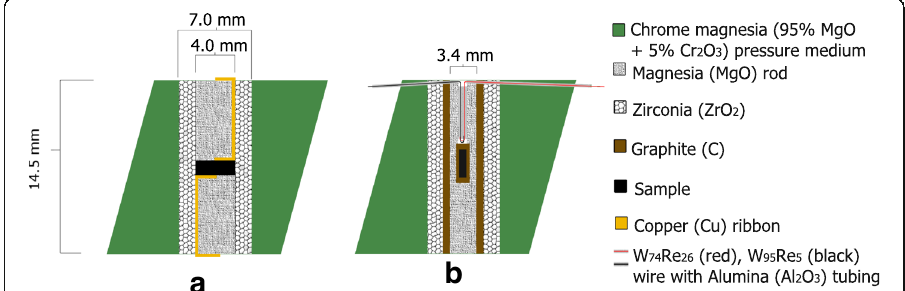
Fig. 3 Schematic assembly setup for the performed calibration experiments. a The 18/11 OEL/TEL assembly for room temperature calibration experiments. b The 18/11 OEL/TEL assembly for high temperature calibration